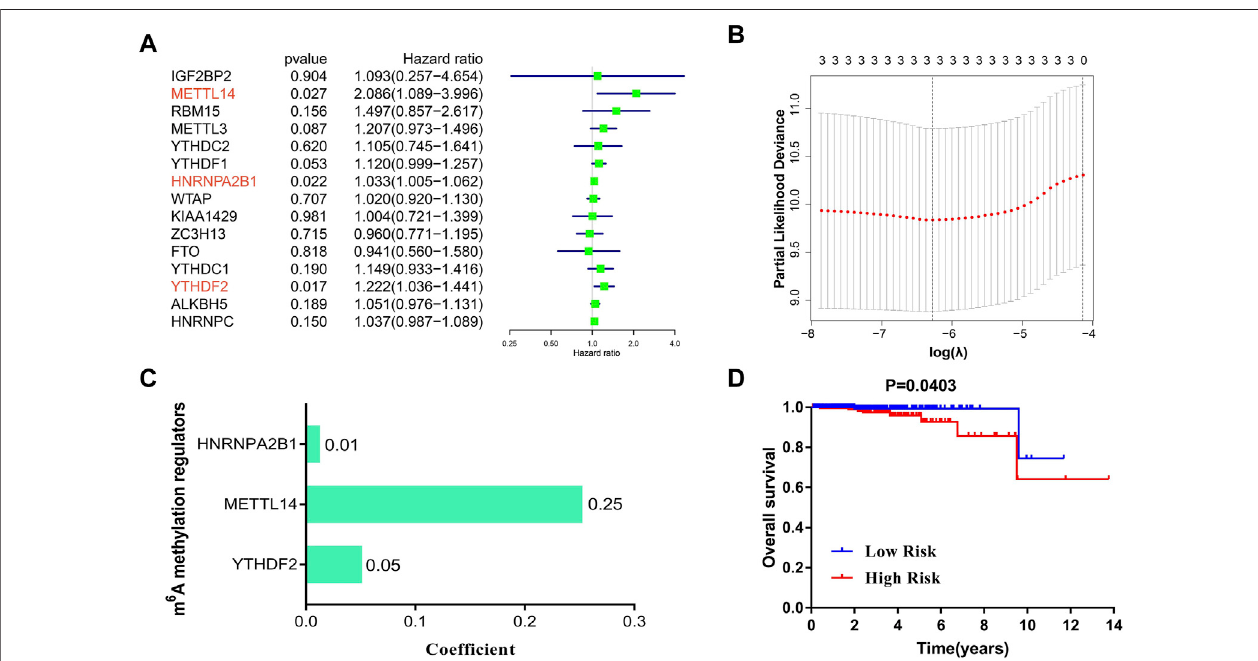
FIGURE3 | The construction of aLASSO-Cox diagnosticscoring model based on m 6 A regulators. (A) Univariate analysis ofthe 15 regulators on overall survivalof PCa patients. (B,C) The coef fi cients ofthree m 6 A regulators are calculated byusing the LASSO algorithm. (D) Kaplan – Meier analysis ofPCa patientswith low-risk (blue) and high-risk (red) groups in TCGA cohorts (N = 492).